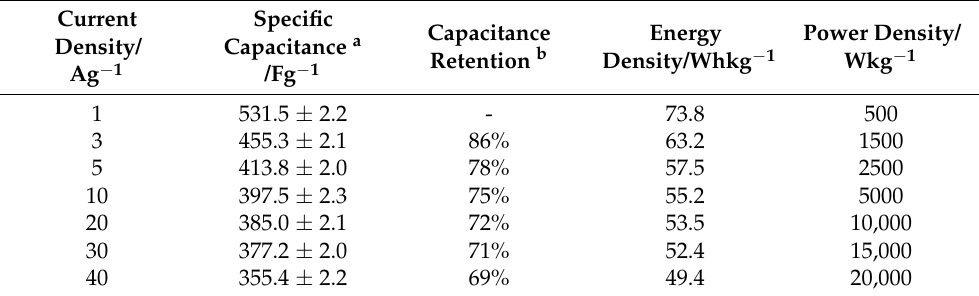
Table 2. Specific capacitances, retentions and respective gravimetric energy and power densities of FTO-PANI symmetric supercapacitor at varying current densities.